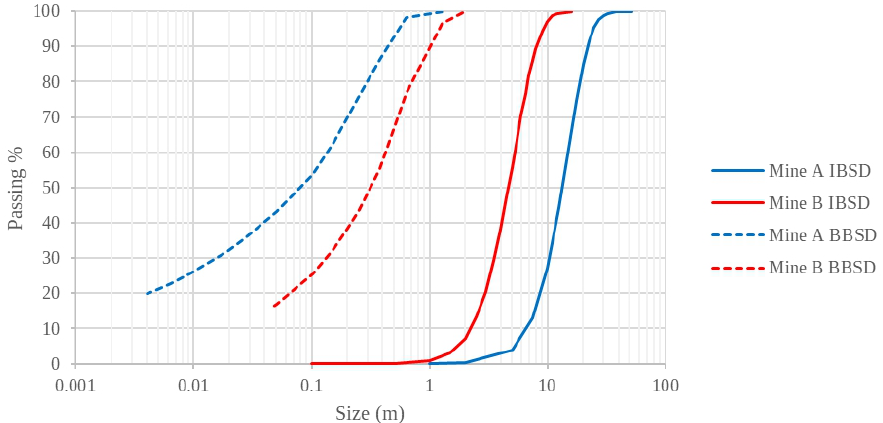
Figure 6. Particle size distribution plots for Mines A and B. The IBSDs estimated using DFN models are illustrated with solid lines. The BBSDs measured using image analysis for Mines A and B are drawn using dashed lines. BBSD measurement is described in Section